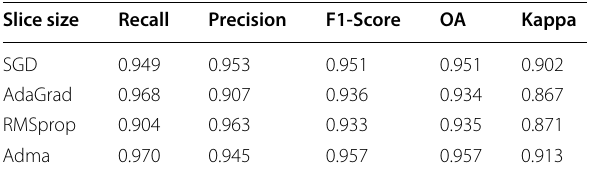
Table 4 Evaluation of the proposed model with the different optimizer on dataset 1